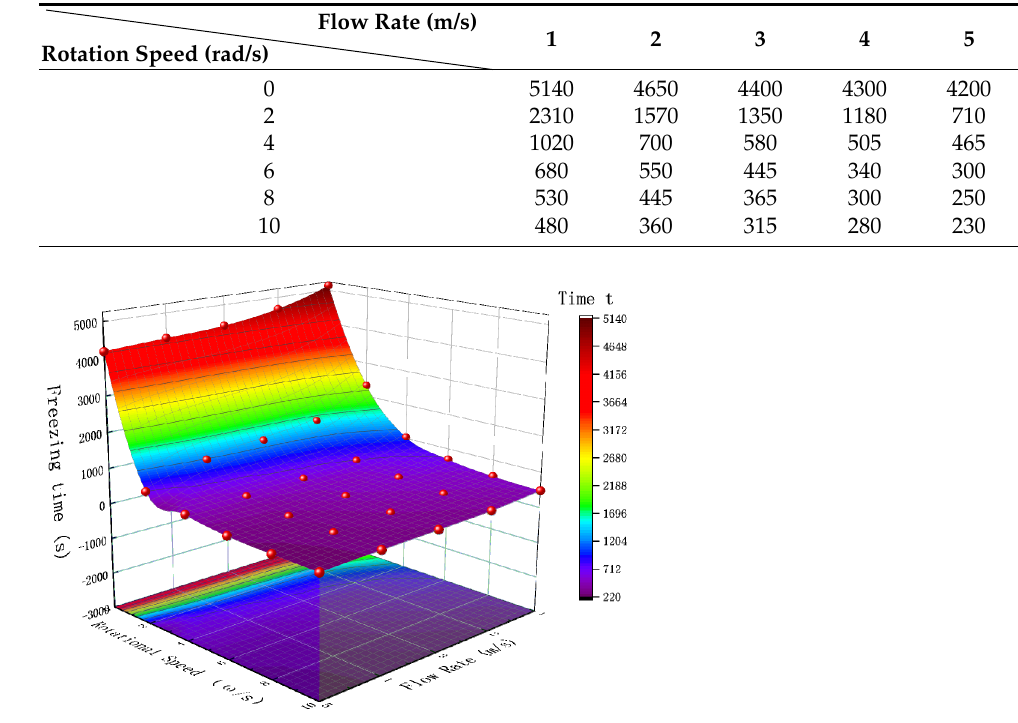
Table 7. Record of time taken for the center of the pork to reach − 18 °C with changing flow rate and rotational speed.